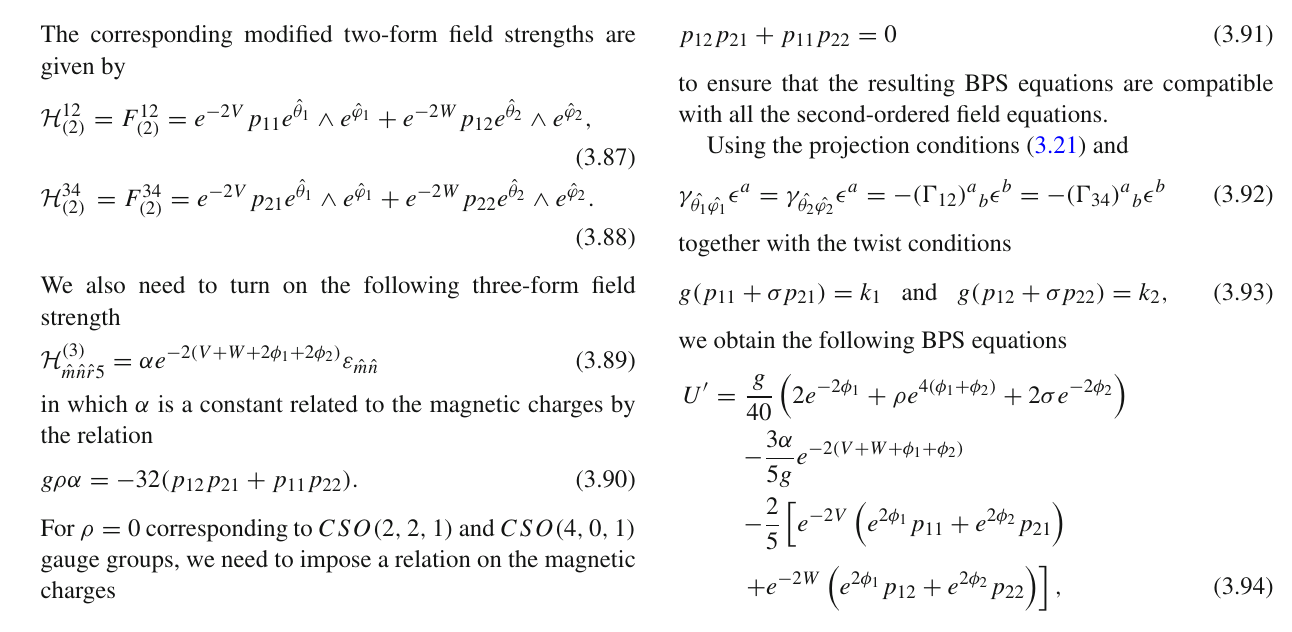
Fig. 12 RG flows from the N = 4 AdS 7 critical point to the AdS 3 × H 4 fixed point and curved domain walls for SO ( 4 ) twist in SO ( 5 ) gauge group. The blue, orange, green and red curves refer to g = 8 , 16 , 24 , 32,